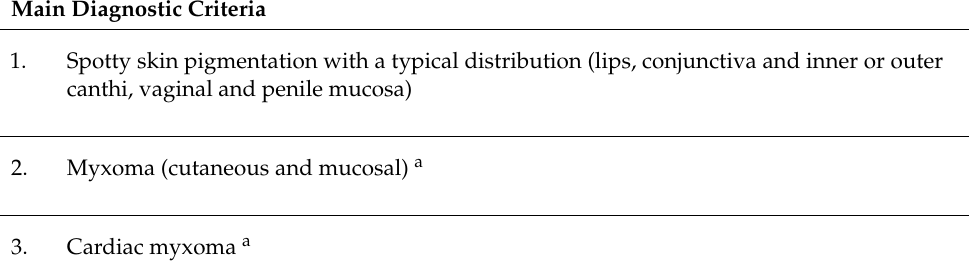
Table 1. Diagnostic criteria for Carney Complex